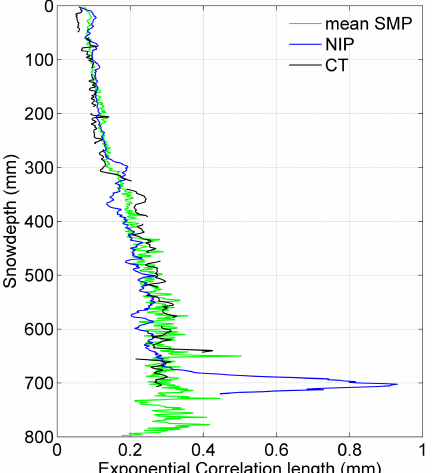
Figure 5. Correlation length profile derived by SMP (green), µ CT (black) and NIP (blue). The blue line is the correlation length de- rived from the SSA measured by NIP according to Mätzler